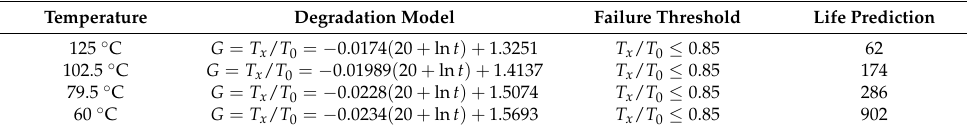
Table 5. Degradation model and predicted life of closing time at different